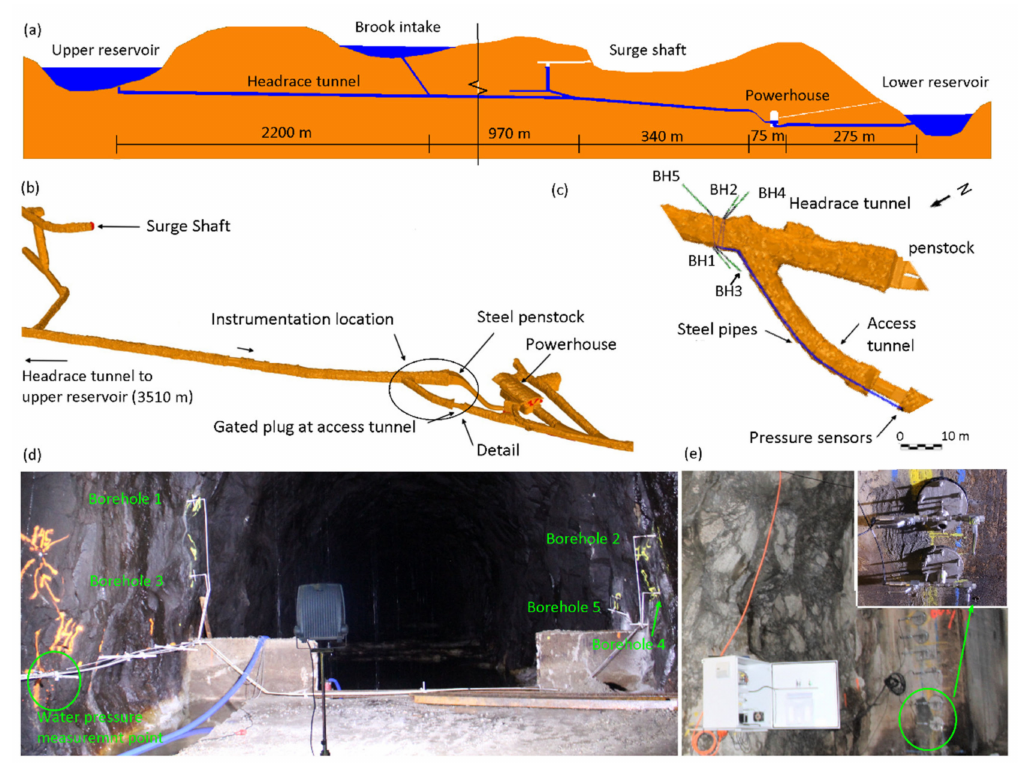
Figure 7. Longitudinal section of Roskrepp waterway ( a ), instrumentation location ( b ), and detailed view of the setup with boreholes BH1–BH5 ( c ), view of the instrumented tunnel section, looking upstream ( d ), and view of pressure sensors and datalogger in the access tunnel ( e